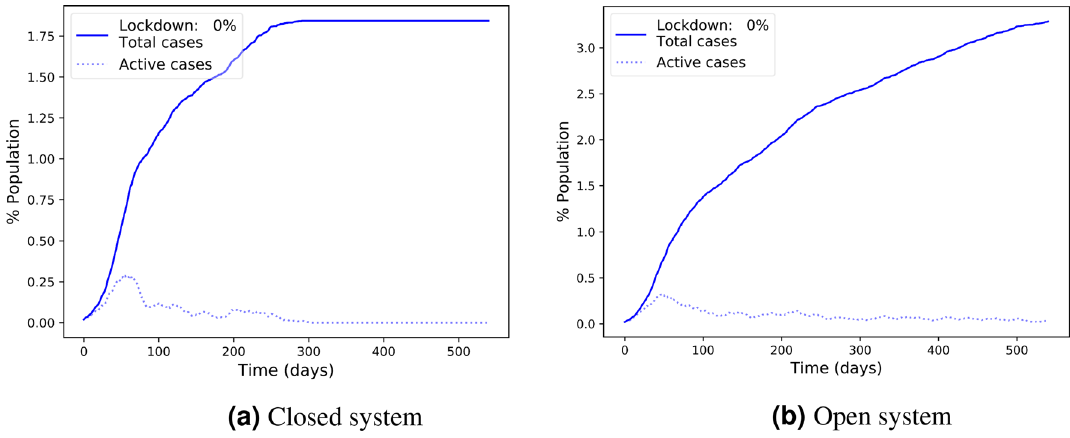
Figure 6. Track and test without any lockdown: outbreak